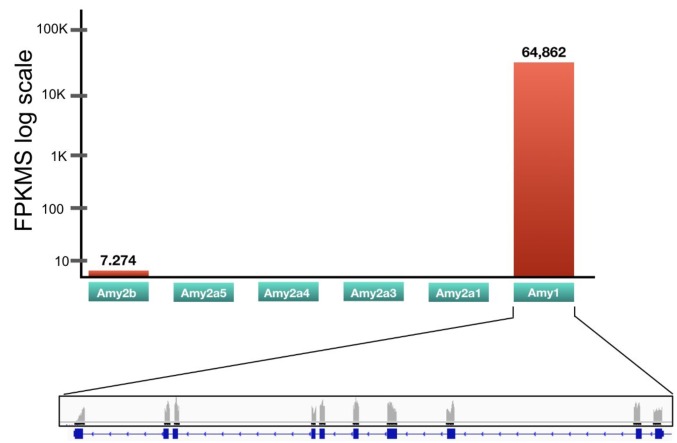
RNA-sequencing data for expression of amylase genes in mouse parotid salivary gland.Green boxes on the x-axis represent the gene order on the mouse reference genome. The y-axis is drawn in log scale and represents the fragments per kilobase of exon per million reads (FPKMS) from RNA sequencing. Vertical bars designate the average FPKMS read coverage for RNA from two adult mice (12 weeks of age) for their parotid salivary glands. The gene schematic diagram displays the RNA sequencing coverage across the exons of amy1. Data were extracted from Gluck et al. (2016).